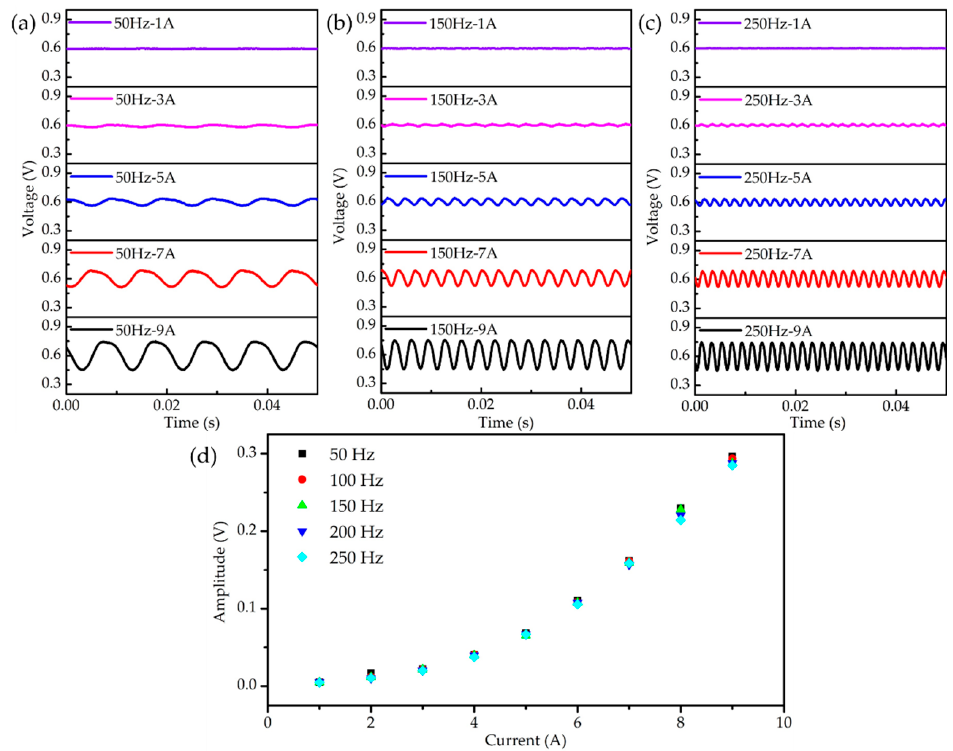
Figure 5. Measured voltage waveforms when the frequency of the AC magnetic field is ( a ) f = 50 Hz, ( b ) f = 150 Hz, and ( c ) f = 250 Hz. The drive currents of AC frequency conversion power supply are 1 A, 3 A, 5 A, 7 A, and 9A, respectively. ( d ) Variation in peak-to-peak amplitude of waveform with driving currents when the frequencies of AC magnetic field are 50, 100, 150, 200, and 250 Hz, respectively.